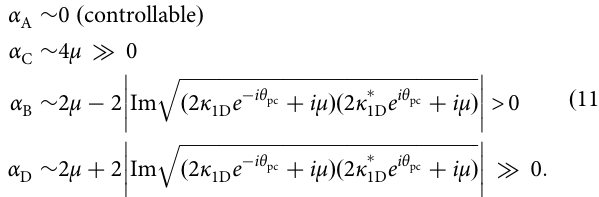
Fig. 2 Physical meaning of Hermitian coupling coef fi cients. a Electric fi eld vectors of the four fundamental waves in a general case. b Electric fi eld vector pairs that have anti-symmetric vectors about the axis of y = x with the amplitudes of R x + R y and S x + S y , where their Hermitian coupling coef fi cients are expressed as κ 1D þ κ 2D (cid:2) and κ (cid:7) þ κ (cid:7) . The resultant anti-symmetric modes are de fi ned as modes A and C. c Electric fi eld vector pairs that have 1D 2D (cid:2) symmetric vectors about the axis of y = x with the amplitudes of R x − R y and S x − S y , where their Hermitian coupling coef fi cient are expressed as κ κ κ (cid:7) (cid:2) κ (cid:7) . The resultant symmetric modes are de fi ned as modes B and 1D (cid:2) 2D (cid:2) and 1D 2D (cid:2) symmetric electric- fi eld pairs ( R x + R y and S x + S y ) in Fig. 2b are þ κ þ κ * represented by κ and κ * as shown in the non- 1D 2D (cid:2) 1D 2D (cid:2) þ κ diagonal terms in Eq. (7), and thus, κ represents the 1D 2D (cid:2) Hermitian coupling coef fi cient for the anti-symmetric modes (which we de fi ne as modes A and C). Similarly, the coupling coef fi cients between the symmetric electric- fi eld pairs ( R x − R y and S x − S y ) in (cid:2) κ (cid:2) κ * Fig. 2c are represented by κ and κ * , and thus 1D 2D (cid:2) 1D 2D (cid:2) κ (cid:2) κ represents the Hermitian coupling coef fi cient for the 1D 2D (cid:2) symmetric modes (which we de fi ne as modes B and D).